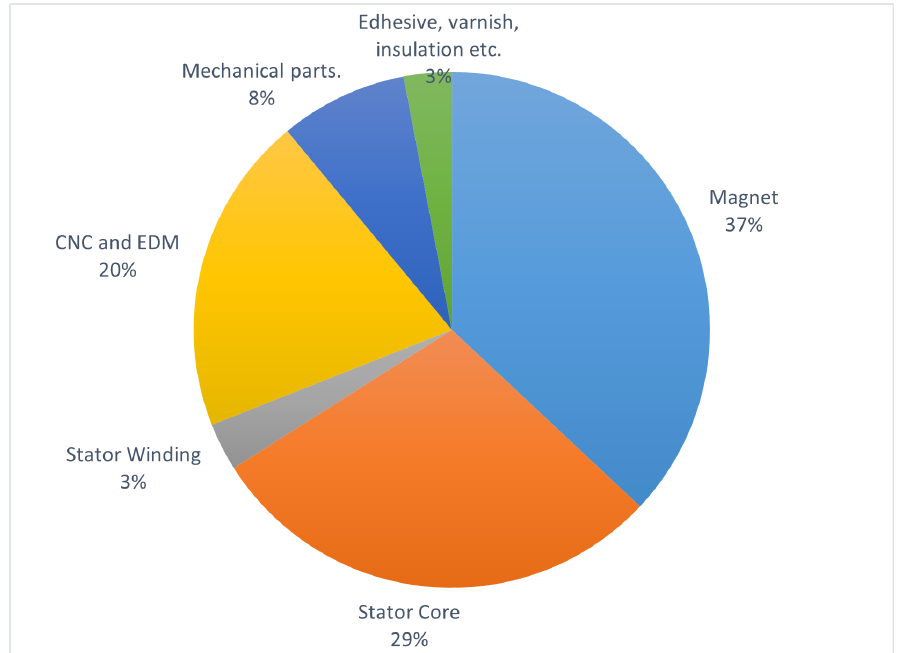
Figure 26. Percent distribution of the cost categories of the proposed